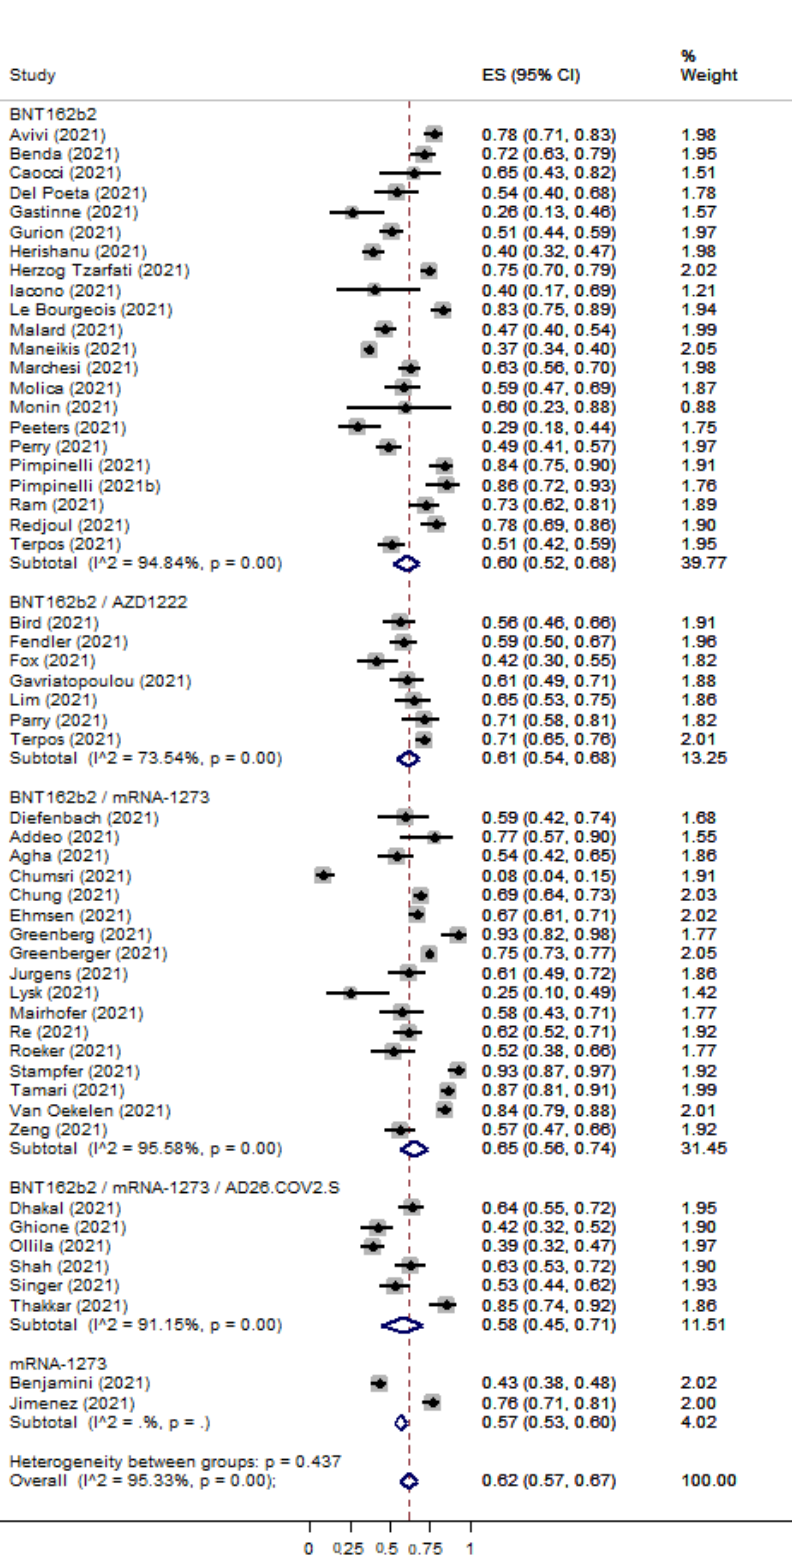
Figure 5. Pooled EffectSize (ES) for the immune seroconversion rates of patients with solid tumors after the second dose of COVID-19 vaccine. [7,15,17,18,20,22–25,28,35–40,40,42–49,52–55,57–61,63,66–69,71,72,74,80–82,85,86].